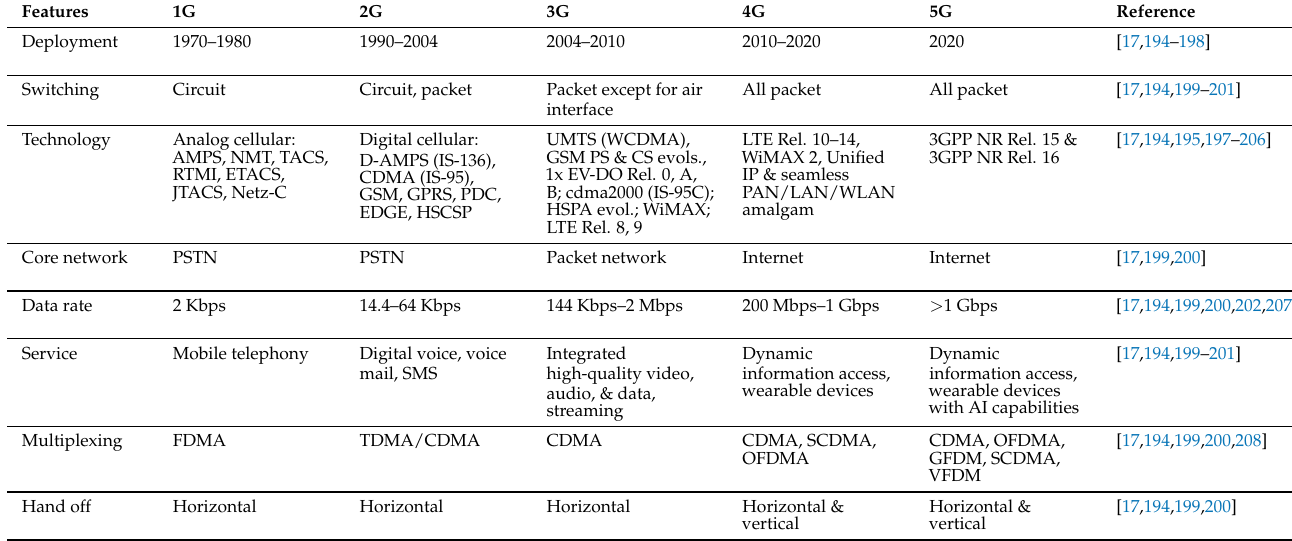
Table 6. Mobile network evolution.